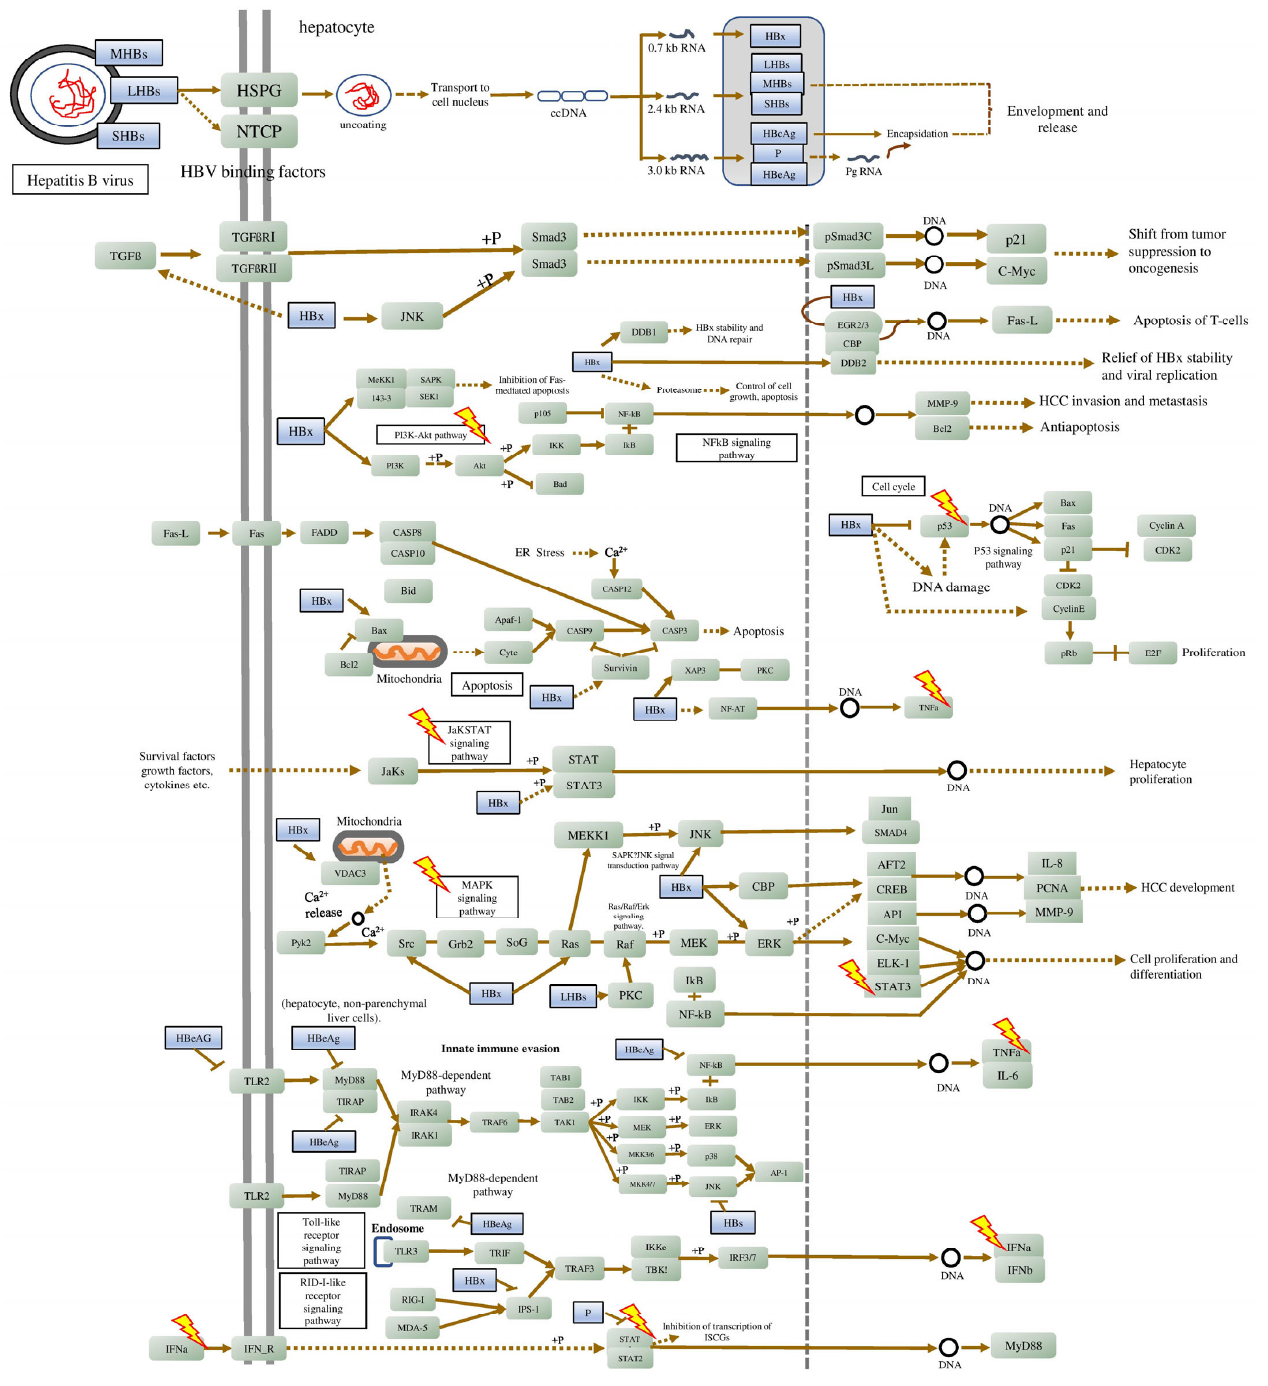
Figure 4. Major checkpoints to be affected by the phytocompounds. Affected checkpoints.